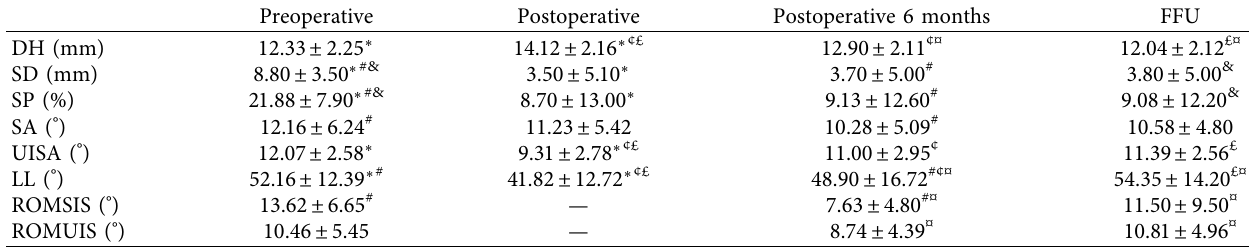
Table 3: Radiological assessments (mean ± SD/M ± IQR).